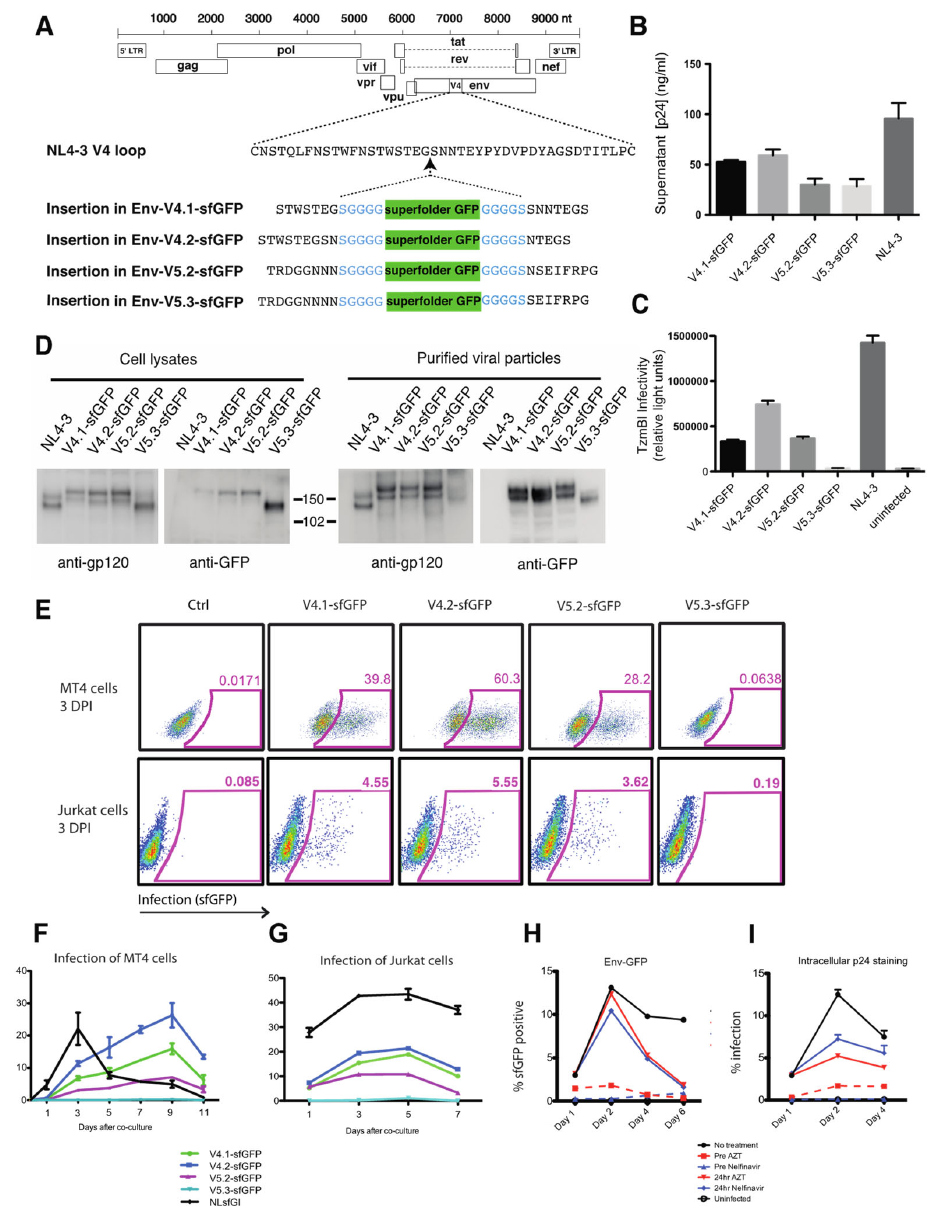
Figure 1. Construction of infectious HIV clones with fluorescent Env carrying sfGFP inserted into V4 or V5 domains. ( A ) sfGFP is inserted into HIV-1(NL4-3) in V4 or V5. ( B ) Virus production by fluorescent Env HIV constructs following transfection of 293 T cells measured by p24 ELISA. ( C ) Cell-free virus infectivity was tested by infection of indicator cell line, Tzm-bl. Tzm-bl cells were infected with viral supernatants containing equivalent p24 antigen. ( D ) Western blot analysis of lysates of transfected 293 T cells or of virus particles harvested from transfected cell supernatants and purified through a 20% sucrose cushion. Blots were probed with anti ‐ gp120 or anti ‐ GFP antibody. Viral supernatants and cell lysates were collected at 48 h post transfection. ( E ) Infection of Jurkat cells or MT4 cells with virus was assessed on day 3 post infection. ( F ) Infection of MT4 cells initiated by co ‐ culture with HIV ‐ nucleofected Jurkat T cells. Flow cytometry was used to monitor the fraction of MT4 cells infected over time. ( G ) Infection of Jurkat cells initiated by spinnoculation of Jurkat T cells with cell ‐ free virus. Flow cytometry was used to monitor the fraction of Jurkat cells infected over time. ( H ) Growth curve of HIV Env V4.2 ‐ sfGFP in Jurkat cells with and without treatment of AZT and Nelfinavir prior to or 24 hr after infection measured by Env ‐ GFP flow cytometry and ( I ) intracellular p24 staining.